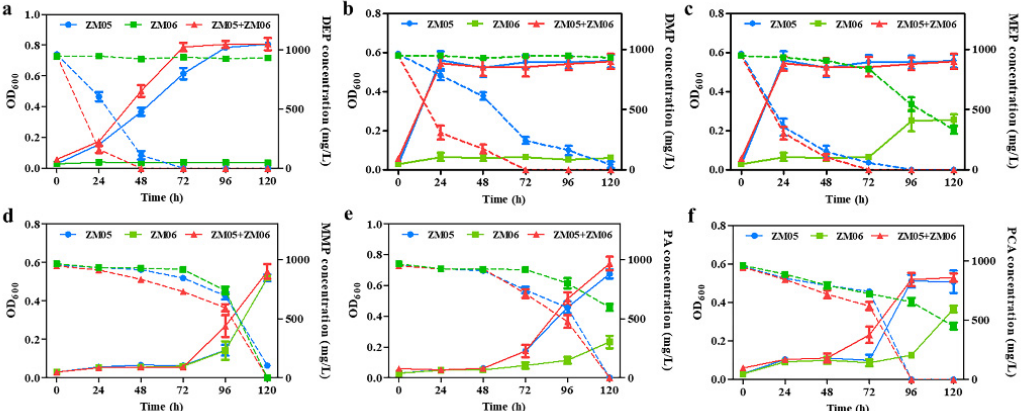
Figure 3. Growth and degradation characteristics of ZM05 (blue), ZM06 (green), and coculture (red) of ZM05 and ZM06 when supplemented with DEP ( a ), DMP ( b ), MEP ( c ), MMP ( d ), PA ( e ) or PCA ( f ) as the sole carbon source under Cd(II) contamination. The solid line represents the OD 600 , and the dotted line represents the residual concentration of the carbon source in the medium. All data are shown as the mean ± SE.